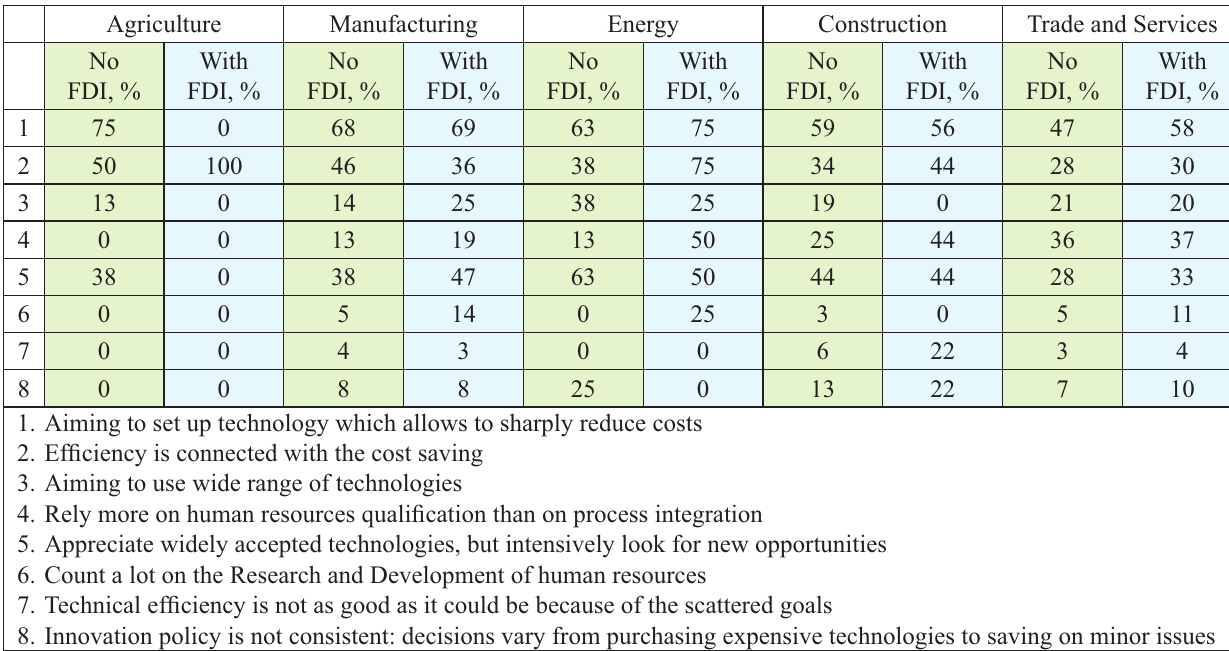
Table 3. Innovation strategies of businesses with and without